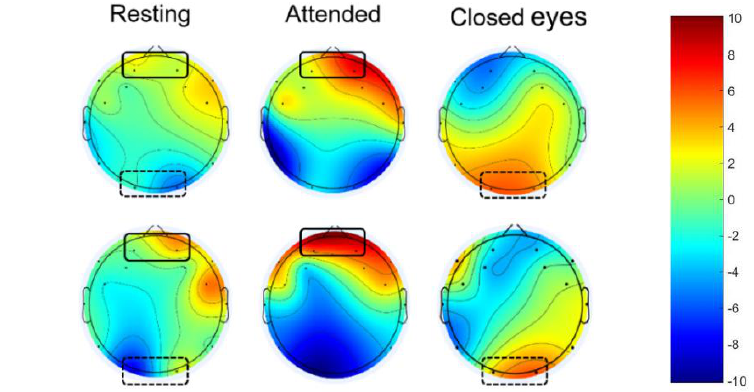
Figure 6. Examples of topographic brain maps of alpha power from EEG while subjects 1 and 2 performed spatial attention and closed eyes.